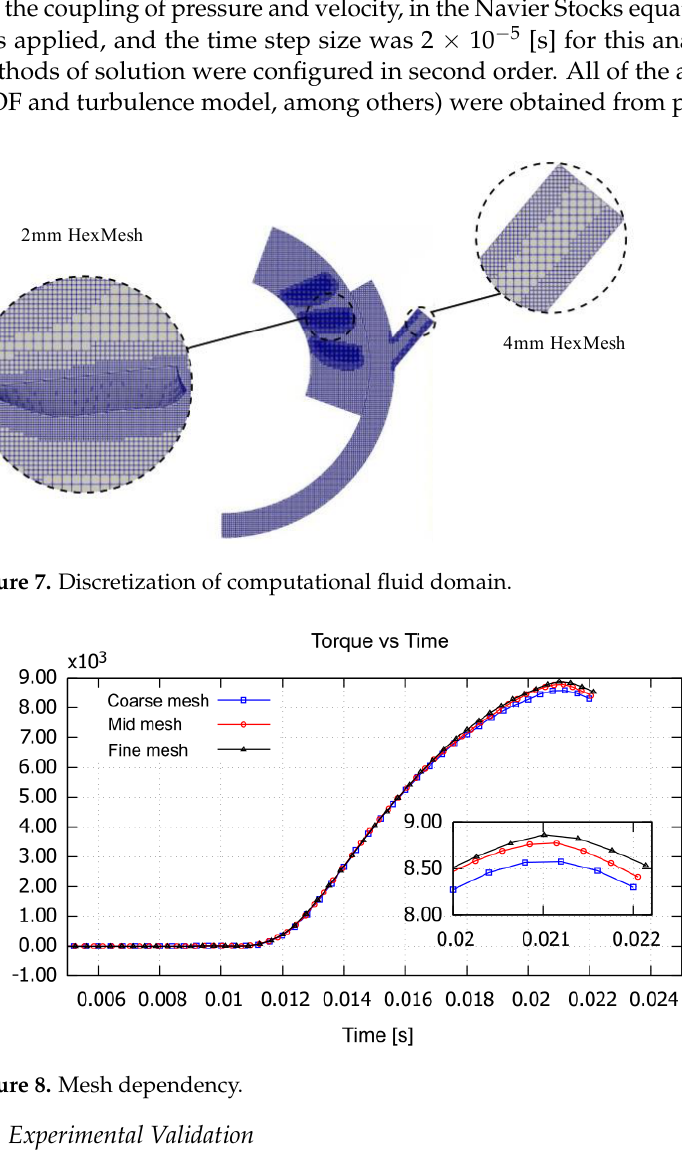
Figure 8. Mesh dependency.